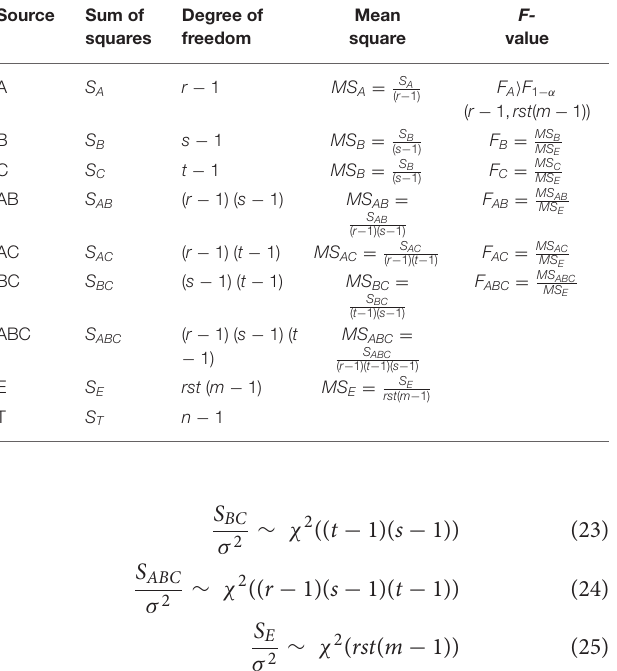
TABLE 1 | Three-factor analysis of variance of interaction effects. Source Sum of Degree of squares freedom